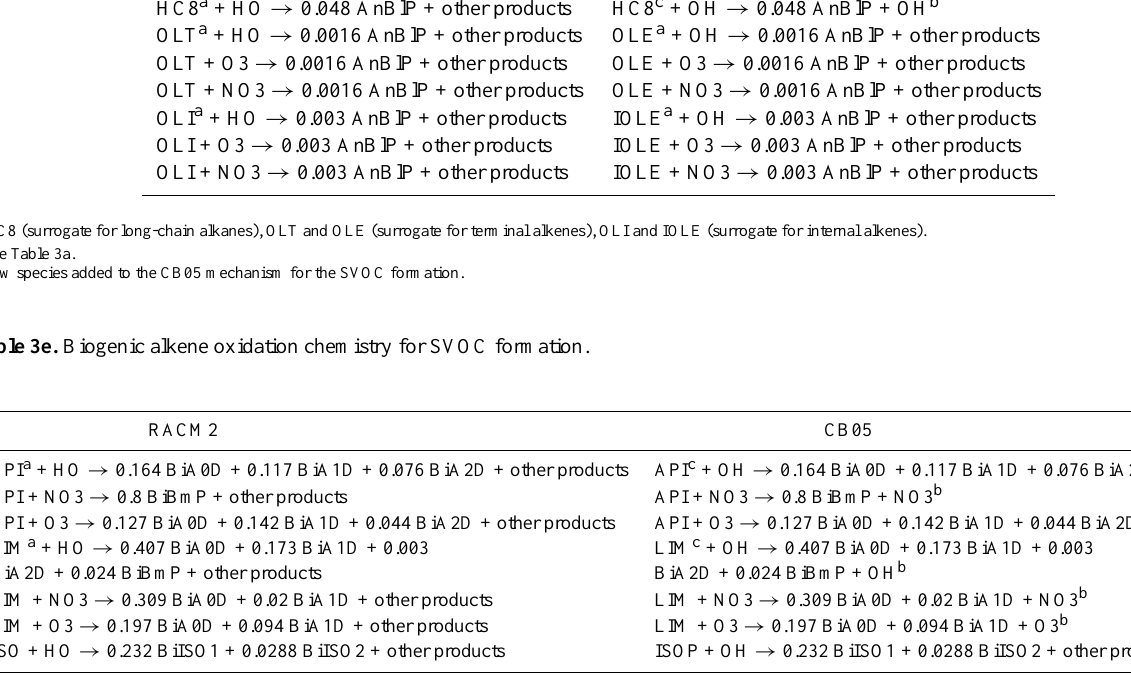
Table 3d. Long-chain alkane and anthropogenic alkene oxidation chemistry for SVOC formation. RACM2 CB05 HC8 a + HO → 0.048 AnBlP + other products HC8 c + OH → 0.048 AnBlP + OH b OLT a + HO → 0.0016 AnBlP + other products OLE a + OH → 0.0016 AnBlP + other products OLT + O3 → 0.0016 AnBlP + other products OLE + O3 → 0.0016 AnBlP + other products OLT + NO3 → 0.0016 AnBlP + other products OLE + NO3 → 0.0016 AnBlP + other products IOLE a + OH → 0.003 AnBlP + other products IOLE + O3 → 0.003 AnBlP + other products OLI + NO3 → 0.003 AnBlP + other products